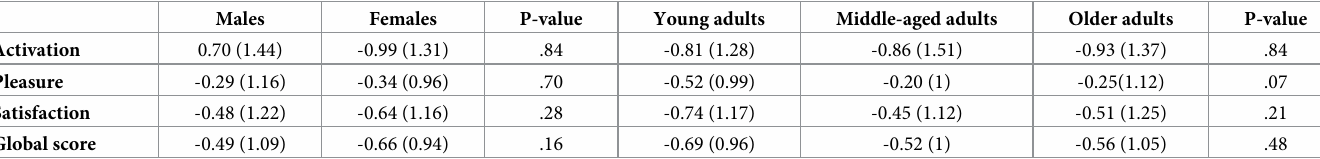
In relation to the effect of gender, when considering the global score of the STS no effect emerged for the before and during pandemic scenarios. However, for the post-pandemic sce- nario the male subsample recorded higher rates of satisfaction than the female subsample [F (1,293) = 553, p � .01]. When considering the three different dimensions of the STS separately, an interaction effect of gender and scenario emerged for activation, with males scoring higher rates of activation than females in the post-pandemic scenario [F (1,293) = 914, p � .01].